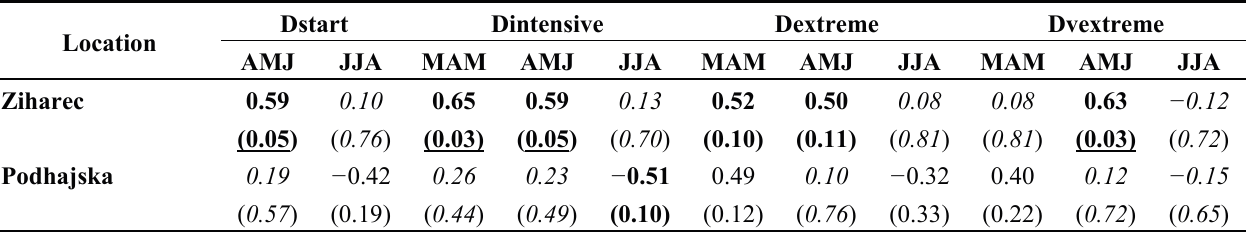
Table 8. Correlation coefficients and p values (in brackets, underlined values are significant) between AMI describing number of dry days and observed MZ yield. No effect: 11 of 22 ; with effect: 7 of 22 .